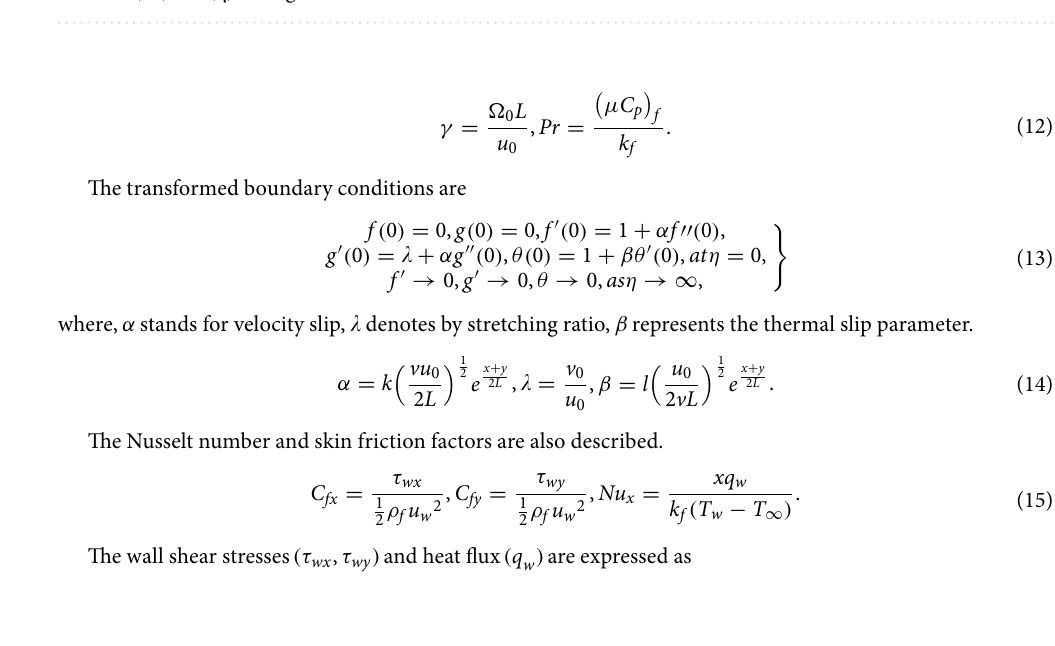
Figure 6. ( a ) Influence on Prandtl number (Pr) of θ(η)for CuO-water nanofluid. ( b ) Influence on Prandtl number (Pr) of θ(η) for Ag-water